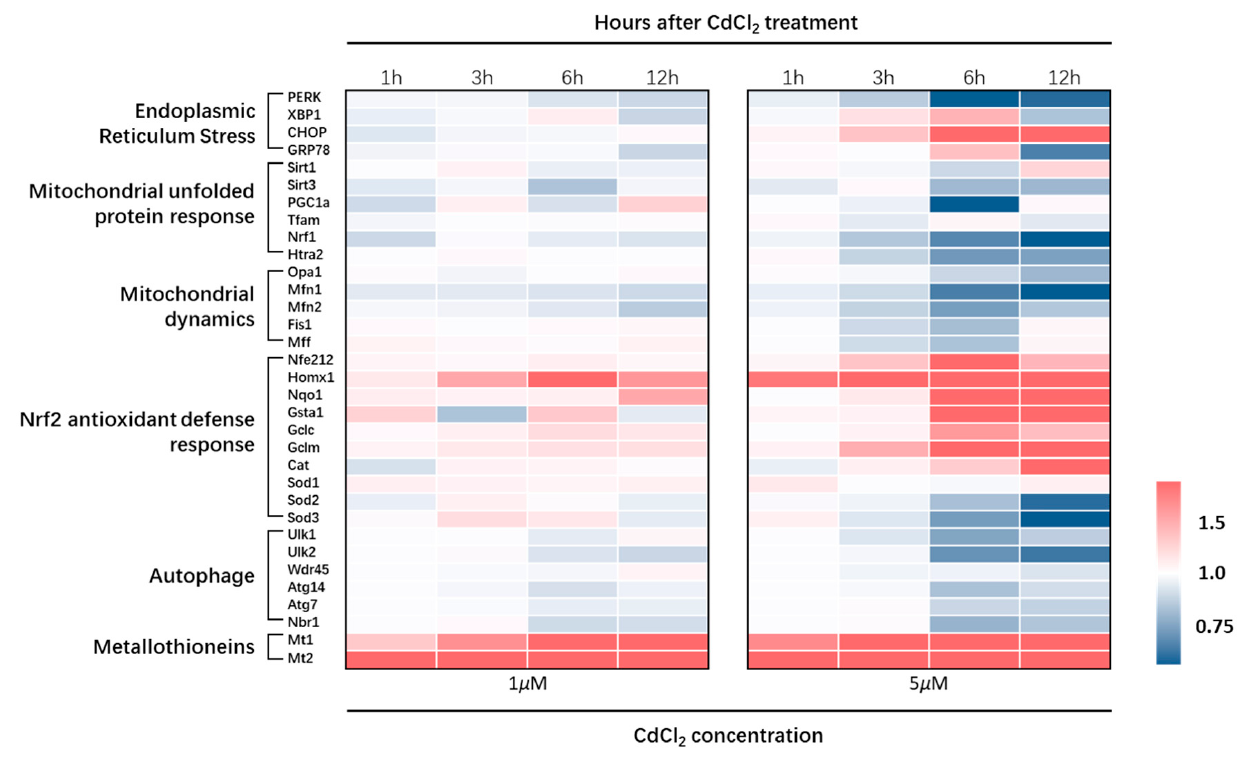
Figure 6. The heat map indicates the dynamic gene expression of cellular response after treatment with CdCl 2 in TM4.